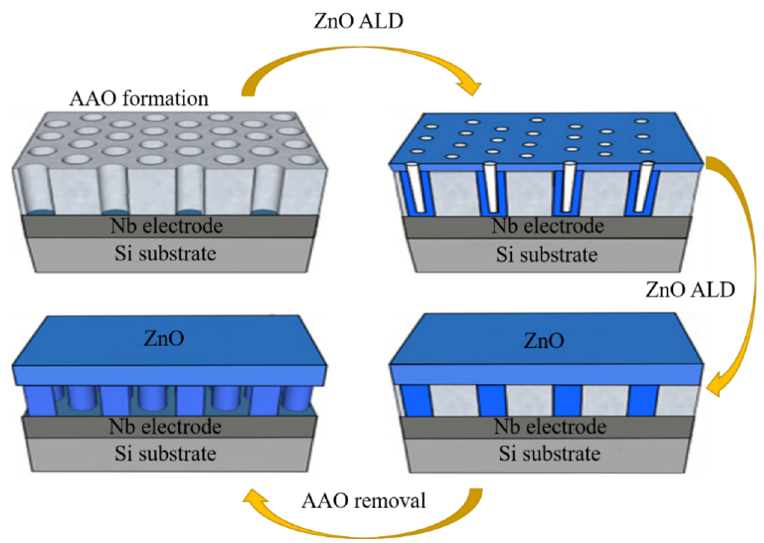
Figure 2. Schematic diagram of ZnO array fabricated by ALD technology. Reprinted from [35] copyright (2013), with permission from Elsevier.